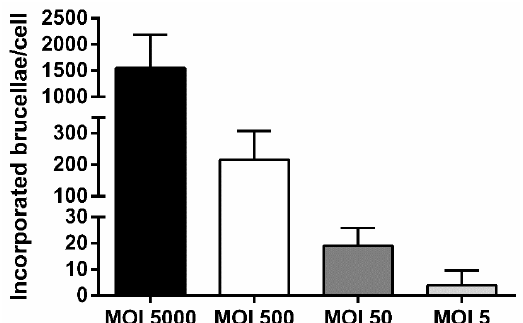
Figure 2. Comparative analysis of incorporated brucellae per cell in ovine macrophages infected with Brucella at various multiplicities of infection (MOIs), 2 days post-infection (quantitative Real-Time PCR). Each MOI condition was repeated 6 times (six different experiments on macrophages of 6 different sheep). Data are represented as means ± standard deviation. MOI: multiplicity of infection.